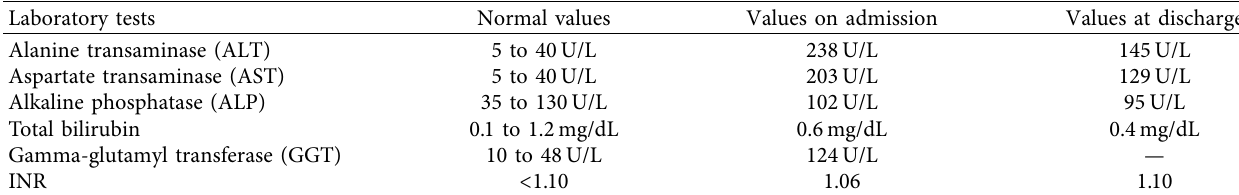
Table 1: Liver function tests.